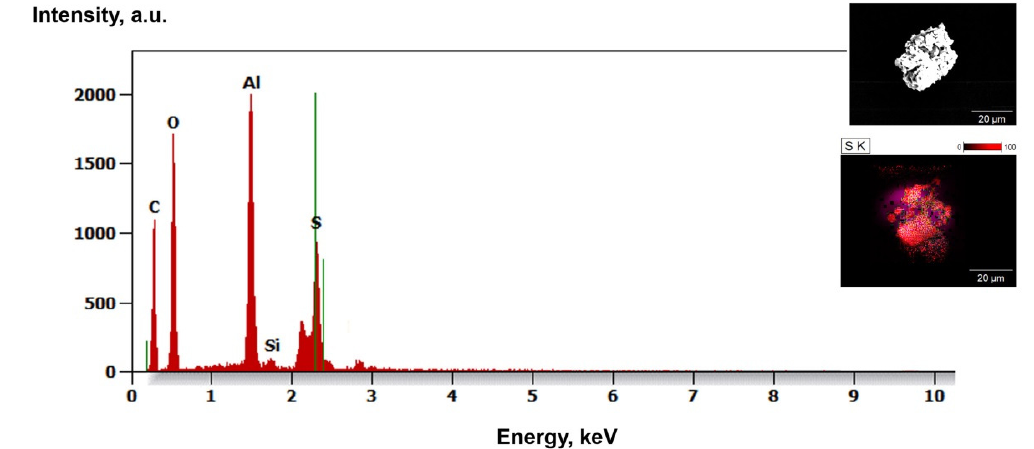
Figure 7. Sulphur contamination in modified alumina sample—Al 2 O 3 _450.